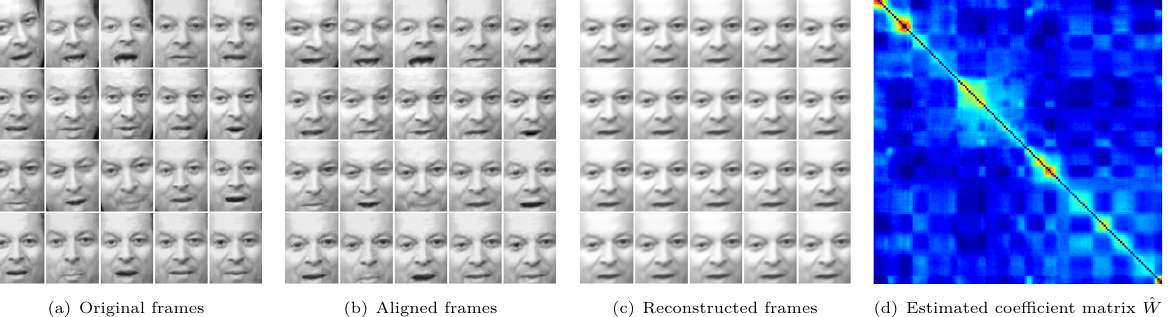
Fig. 5 Experimental results for real face images from a video sequence. (a) 20 original frames of unaligned faces selected from a 140-frame video. (b) Frames after alignment. (c) Reconstructed underlying structures. (d) Coefficient matrix.